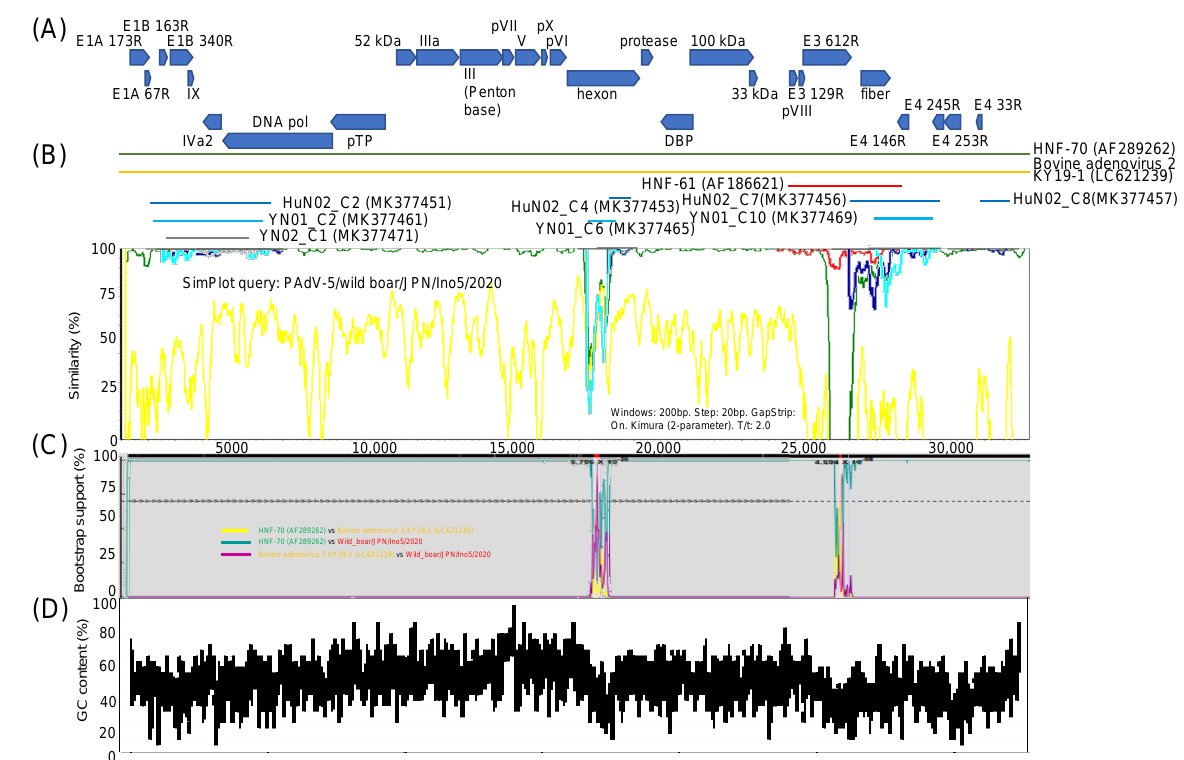
Figure 2. T Schematic illustration of the genome organization of PAdV-5/WB/Ino5/2020/JPN. Blue arrows indicate open reading frames ( A ) Similarity plot of the whole genome of PAdV-5 HNF-70 (green curve), bovine adenovirus 2 KY-19-1 (orange curve), partial genome of PAdV-5 HNF-61 (red curve), PAdV-5 HuN02 (blue curves), PAdV-5 YN01 (light blue curves), YN02 (grey curves), and PAdV-5 Ino5 as query sequence, with a sliding window of 200 nt and a moving step size of 20 nt ( B ) Recombination analysis of PAdV-5 HNF-70 vs. bovine adenovirus 2 KY19-1 (yellow curve), PAdV-5 HNF-70 vs. PAdV-5 Ino5 (green curve), and bovine adenovirus 2 KY19-1 vs. PAdV-5 Ino5 (purple curve) ( C ) Average GC% content per gene across PAdV-5 Ino5 genome ( D